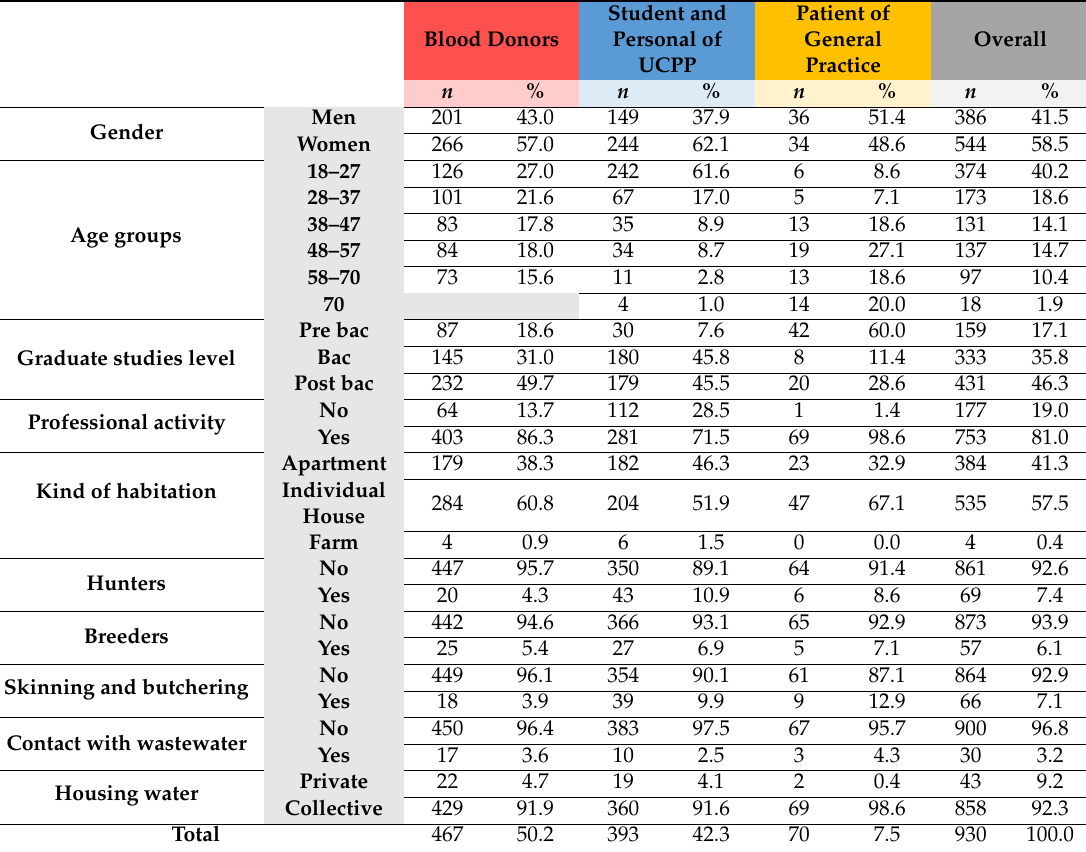
Table A1. Description of population and repartition of individuals included by